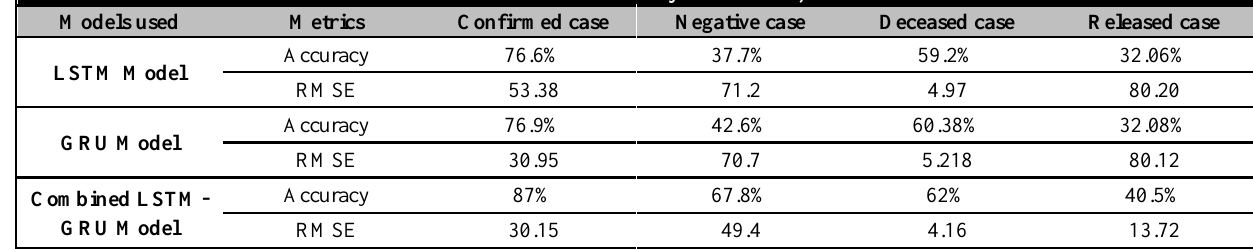
Figure 4: Neural network structure for model Table 1. Prediction Efficiency of Models 1, 2 and 3